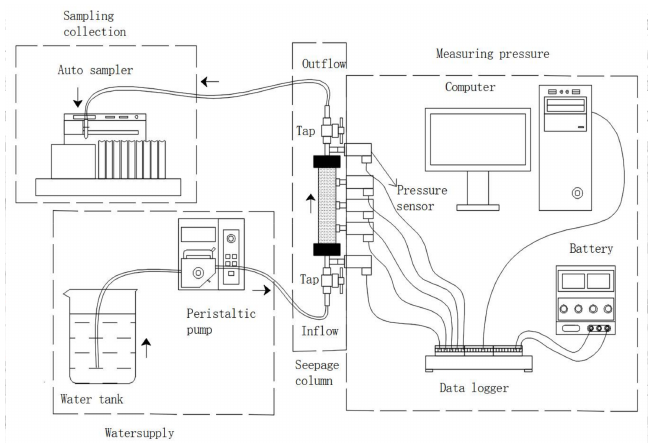
Figure 1. Experimental column set